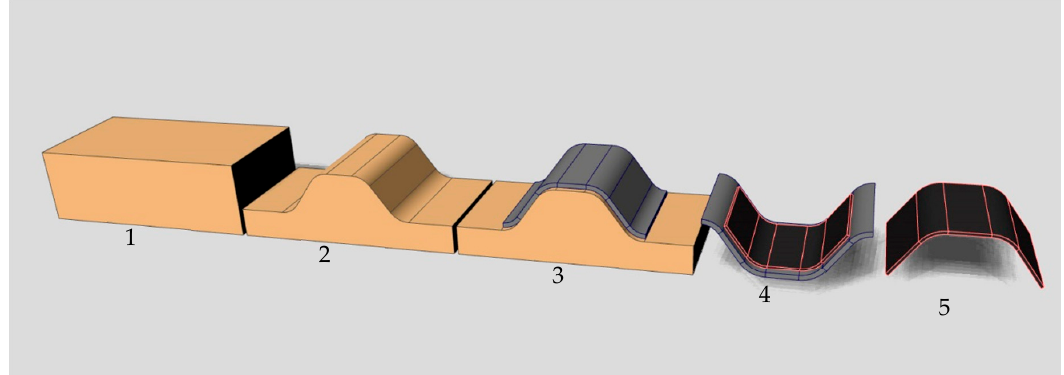
Figure 3. Manufacturing process of recycled carbon fiber (rCF)-based fiber-reinforced polymer (FRP) molds: ( 1 ) master mold is made of polyurethane cuboid; ( 2 ) milled master mold; ( 3 ) draping and infusion of rCF-Mats; ( 4 ) manufacturing of FRP-parts; ( 5 ) final and removed FRP part.